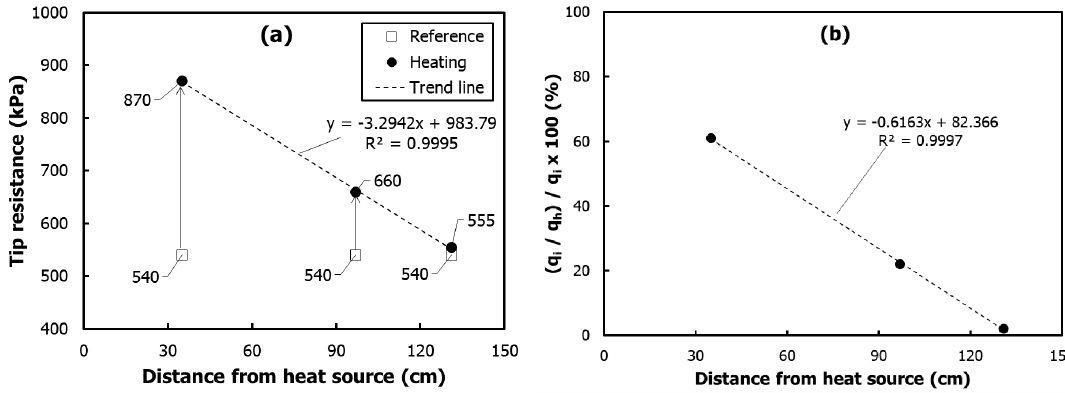
Figure 13. The variation of the tip resistance according to the distance from the surface of the electric heat pipe (Case 4); ( a ) the comparison of the variation in the tip resistance before and after heating; ( b ) the comparison of the increased rate of tip resistance after heating.